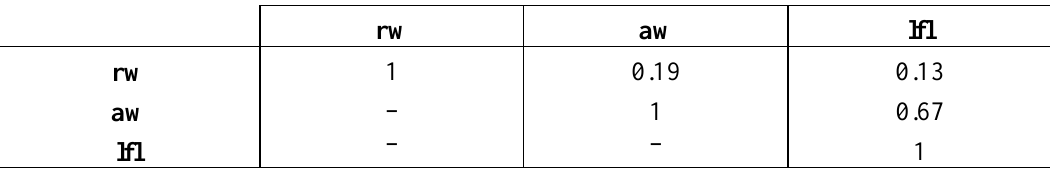
Table 5 : The correlation matrix between herbicidal activity indexes of 1,2,5-oxadiazole N -oxide